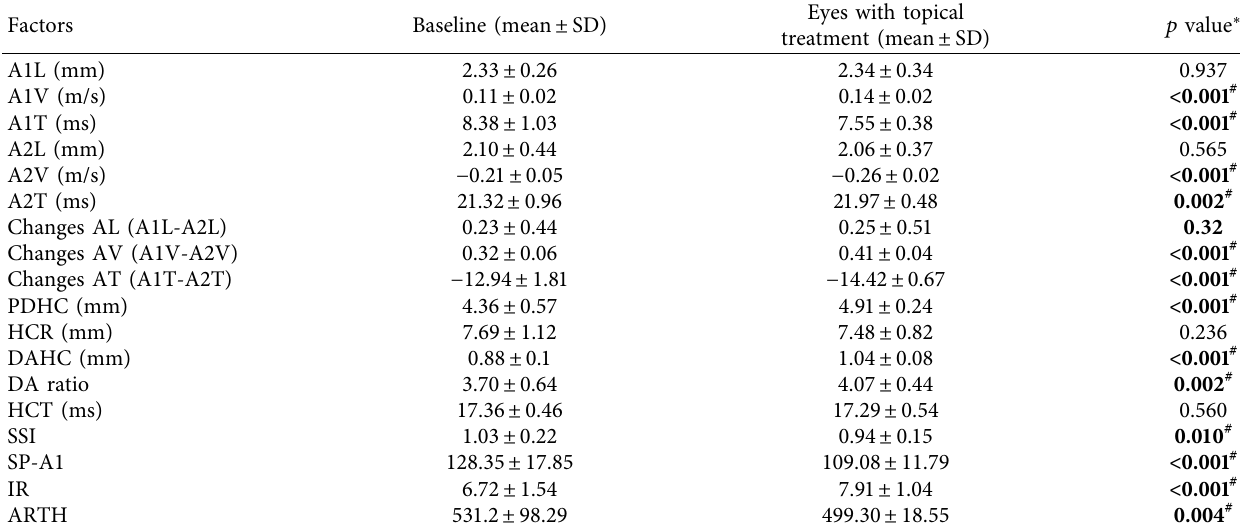
Table 3: Corvis ST parameters before and after glaucoma medication treatment.